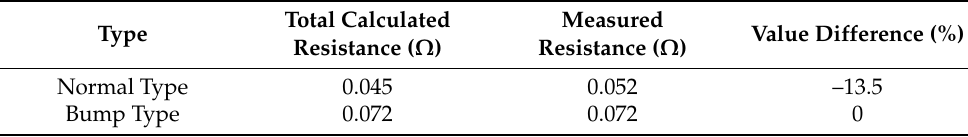
Table 7. Comparison between calculated and measured sensor